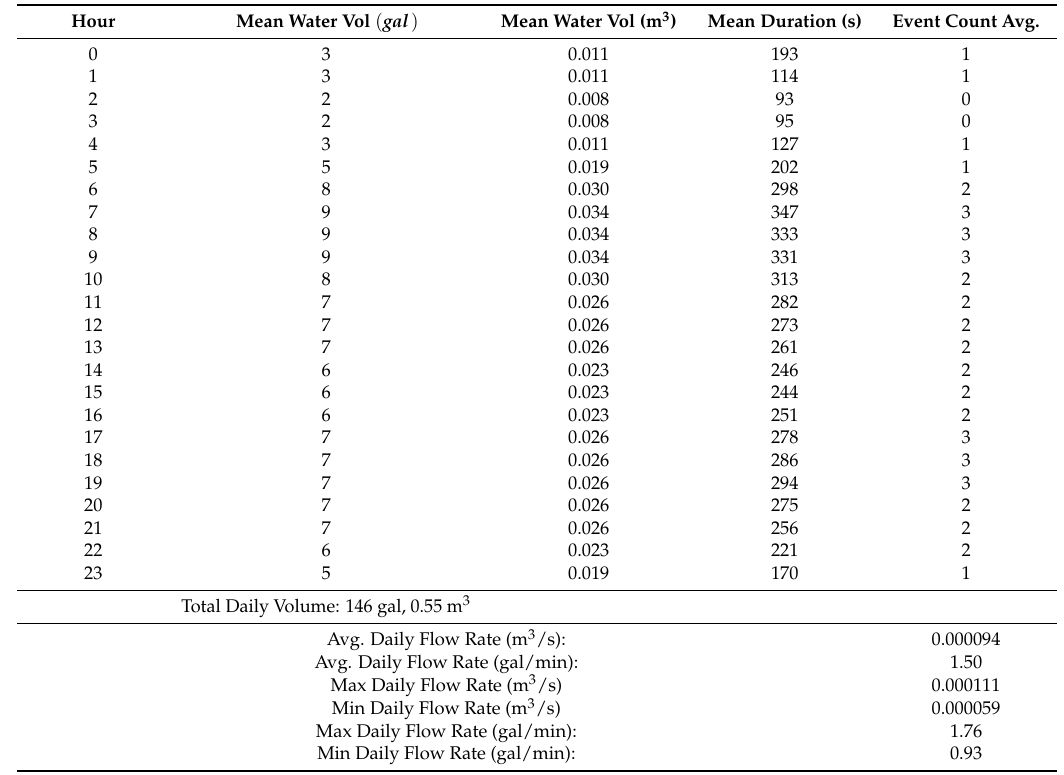
Table A1. Analyzed data from the Residential End Uses of Water 2016 study.